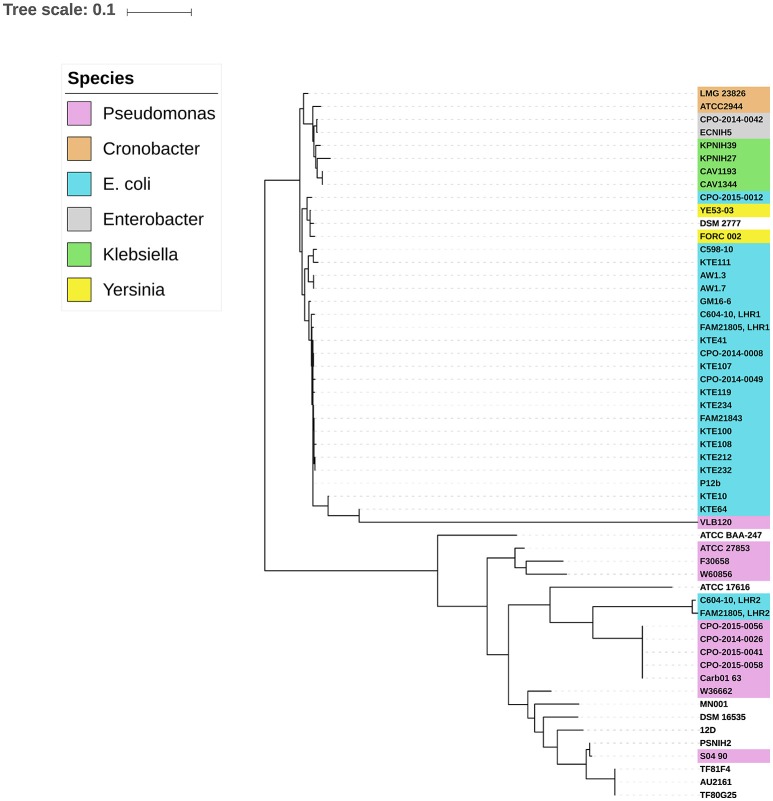
Midpoint-rooted maximum-likelihood phylogenetic tree of aligned LHR sequences (>80% coverage of LHR1FAM21805) from different bacterial species. Two distinct clusters representing predominantly Enterobacteriaceae and strains of Pseudomonas, respectively, are observed. LHR2 of FAM21805 and C604-10 cluster within the Pseudomonas group.